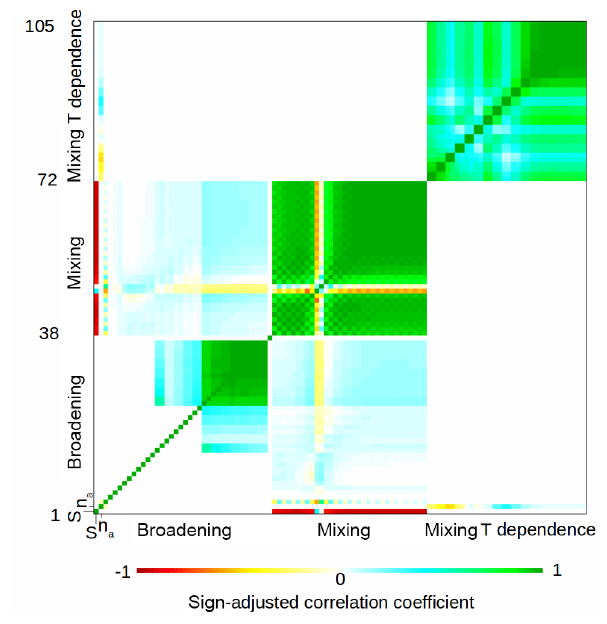
Figure 4. Uncertainty matrix for oxygen absorption as a color-scale image of sign-adjusted correlation coefficients ( ρ SA ). See Eq. (29) in Sect. 4.2 for the definition of ρ SA . The y axis label shows se- lected parameter indexes. The parameters are ordered as follows: no. 1) S (300), no. 2) n a , no. 3) γ 0 (300), nos. 4–37) γ a (300), nos. 38–71) y (300), nos. 72–105) V . The last three parameter types are ordered following the O 2 rotational quantum number N = 1 − , 1 + , 3 − , ... 33 − , 33 +